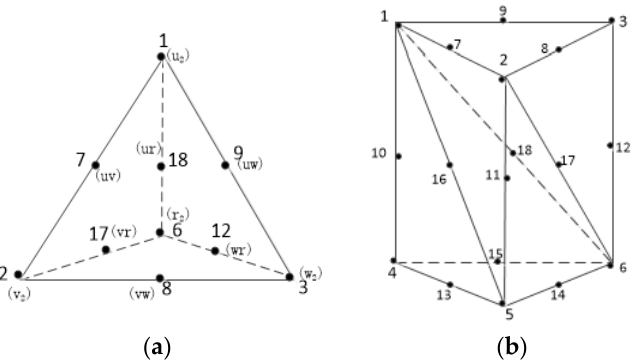
Figure 6. Tetrahedral and triangular prism quadric interpolations. ( a ) Tetrahedral quadric interpolation; ( b ) triangular prism quadric interpolation.